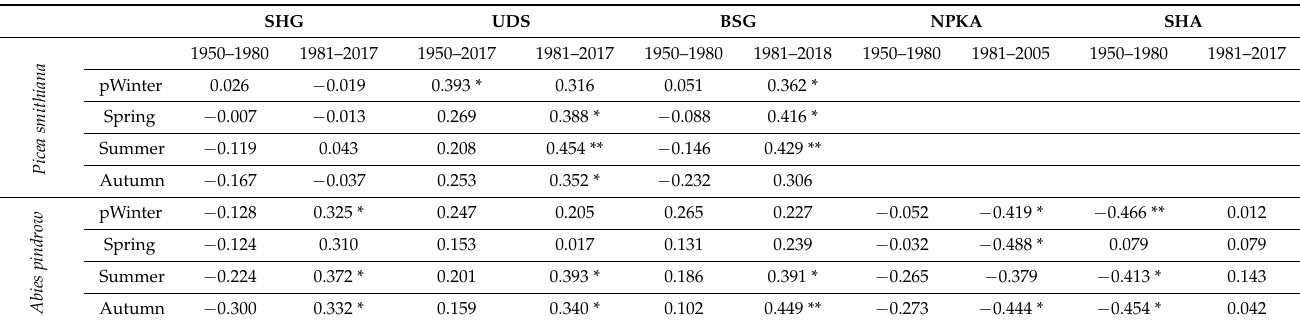
Table 4. Correlation coefficients between seasonal PDSI and the tree-ring index of spruce and fir at